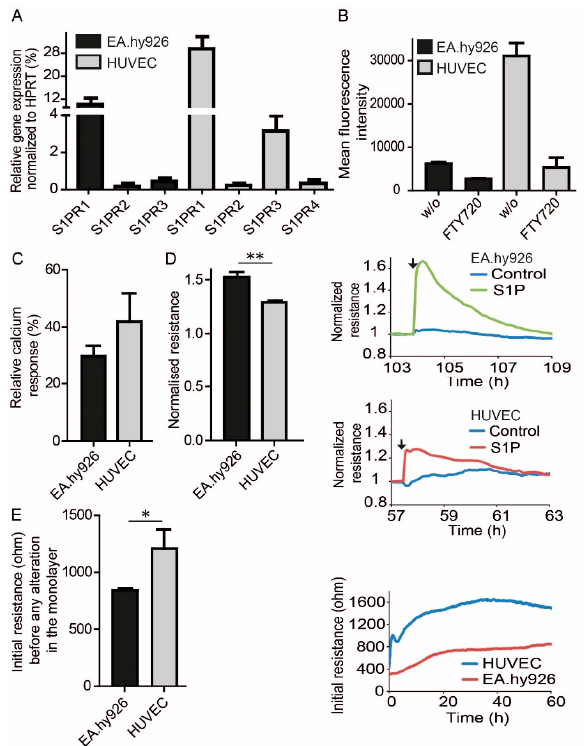
Figure 1. S1PR expression and signaling in EC. ( A ) qPCR analysis of S1PR expression in EA.hy926 and HUVEC. Dara are means ± SEM, n = 3. ( B ) Flow Cytometric analysis cell surface expression of S1PR1 on EC before and after treatment with 1 µM FTY720 overnight. means ± SEM, n = 3. ( C ) Intracellular calcium responses in EA.hy926 and HUVEC upon stimulation with 100 nM S1P. Data were normalized to the response of 10 µM ATP. Means ± SEM, n = 3. ( D ) Resistance following treatment with 1 µM S1P, normalized resistance values were taken at the time of the established maximum resistance after S1P treatment divided by resistance of carrier-treated control cells at the same time and are means ± SEM, n = 3, ** p <0.01, determined by two-sided Student’s t-test. Line plots represent one experiment out of three with black arrows indicating the addition of S1P or vehicle at the corresponding time. ( E ) Difference in initial non-stimulated resistance of EA.hy926 and HUVEC in ECIS measurements 60 h after seeding, means ± SEM, n = 3, * p < 0.05, determined by a two-sided Student’s t-test. Line plot represents one experiment out of three.